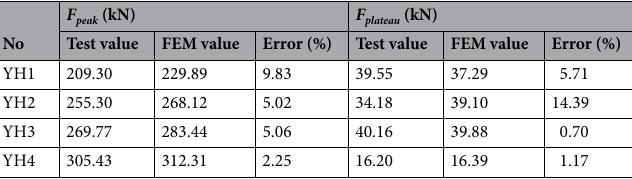
Table 5. Impact force comparison between FEM and test